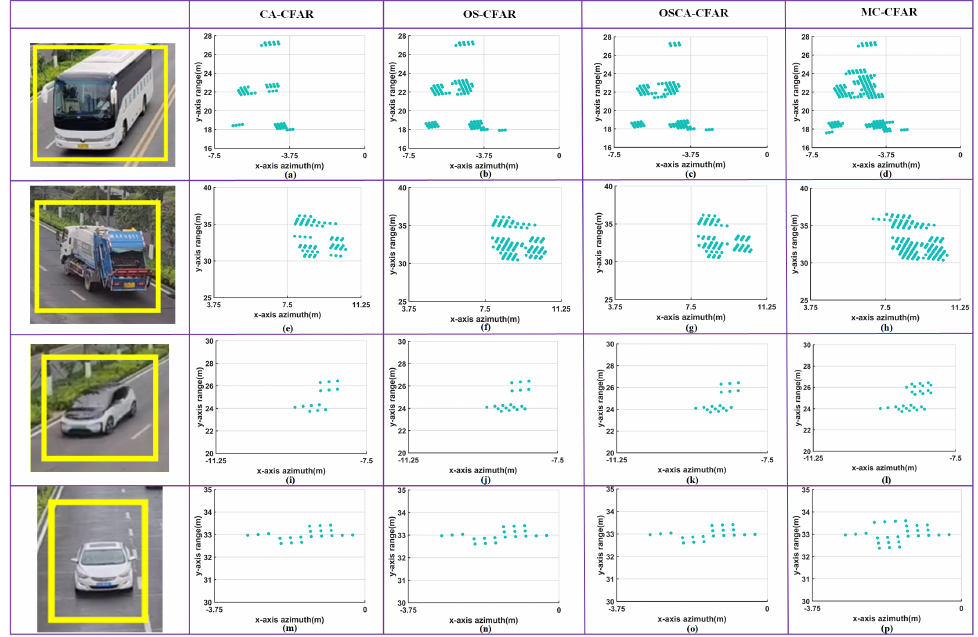
Figure 22. Moving targets CFAR test. ( a ) The CA-CFAR algorithm test result in the case of vehicle 1. ( b ) The OS-CFAR algorithm test result in the case of vehicle 1. ( c ) The OSCA-CFAR algorithm